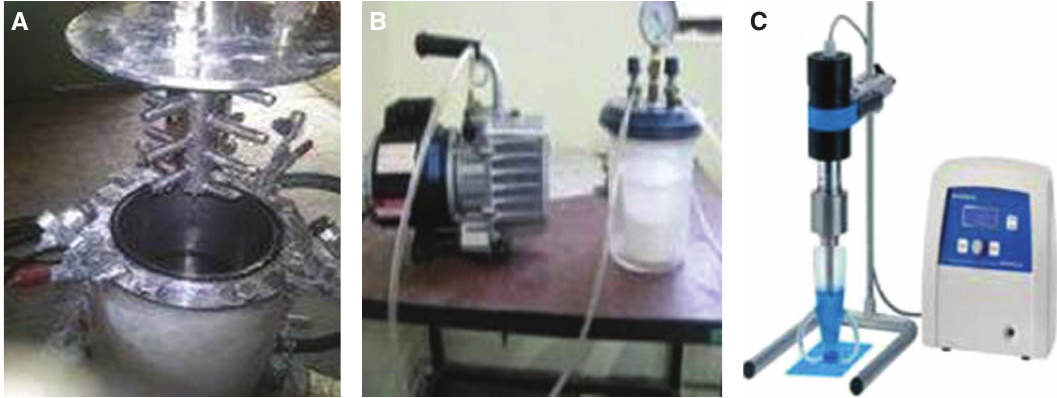
Figure 2 (A) Mechanical blender; (B) vacuum infusion, (C) ultrasonic